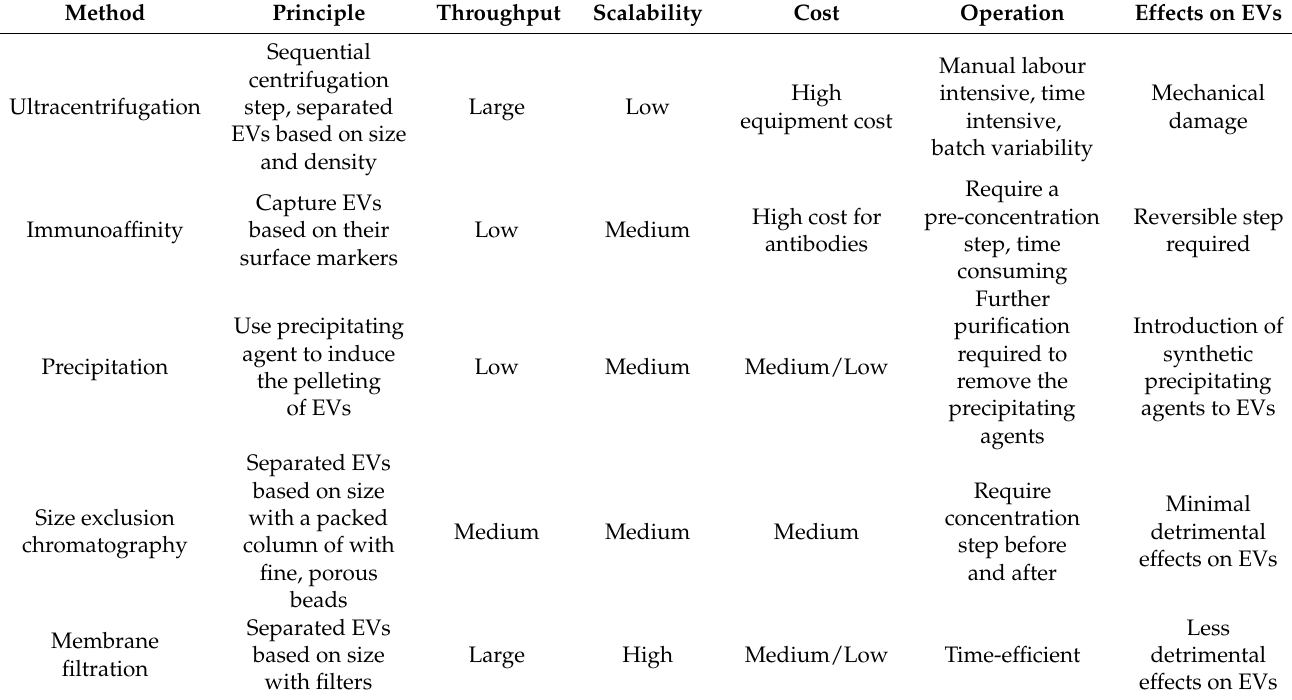
Table 2. Pros and cons of common extracellular vesicle isolation